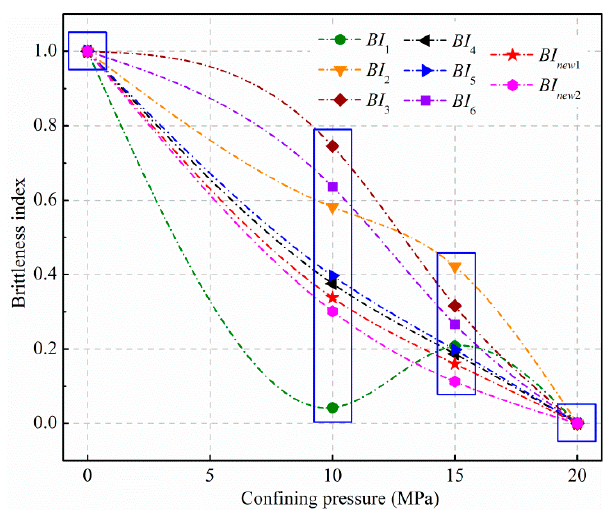
Figure 9. Normalized brittleness indexes of glutenite specimens under triaxial compression.